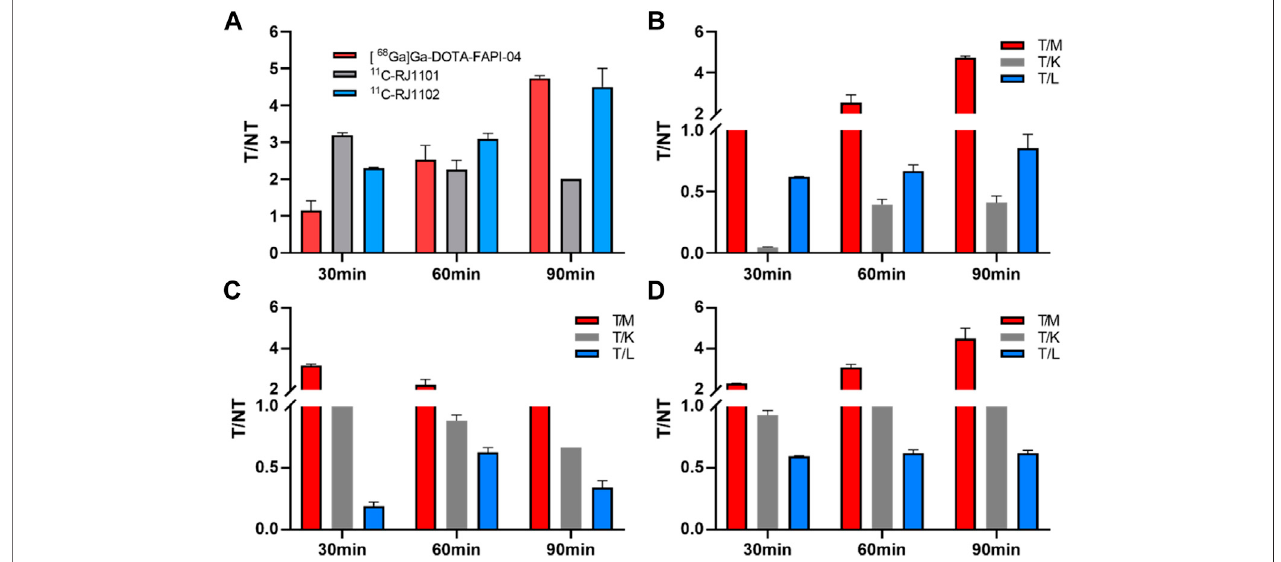
FIGURE 7 | The T/NT ratios in U87MG tumor-bearing nude mice of ( 68 Ga) Ga-DOTA-FAPI-04, 11 C-RJ1101, and 11 C-RJ1102. (A) the T/M ratios of ( 68 Ga) Ga- DOTA-FAPI-04, 11 C-RJ1101and 11 C-RJ1102 after 30,60,and 90 min p.i. (B) theT/M,T/K, and T/Lratios of( 68 Ga) Ga-DOTA-FAPI-04after 30,60,and 90 min p.i. (C) the T/M, T/K, and T/L ratios of 11 C-RJ1101 after 30, 60, and 90 min p.i. (D) the T/M, T/K, and T/L ratios of 11 C-RJ1102 after 30, 60, and 90 min